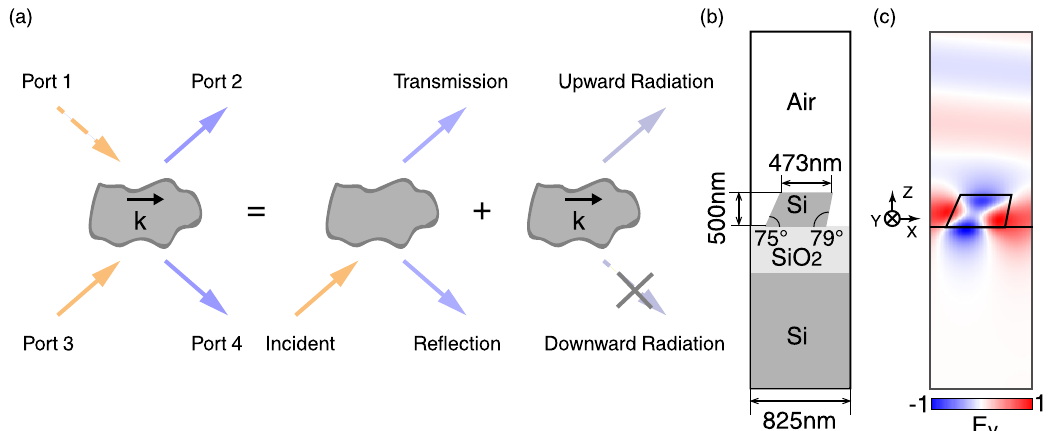
Figure 1: Theory of guided resonance excitation and radiation. (a) A schematic for the four-port TCMT model. Left panel: the guided resonance with in-plane momentum k couples to the outside with four channels. Middle panel: part of the incident from Port 3 reflects and transmits directly without interacting with the resonance. Right panel: the resonance radiates toward the upper and lower sides, while the downward radiation is forbidden by the UGR. (b) The cross-section of field pattern of UGR in a unit-cell calculated from numerical unit-cell for a UGR design on SOI wafer. (c) The E y